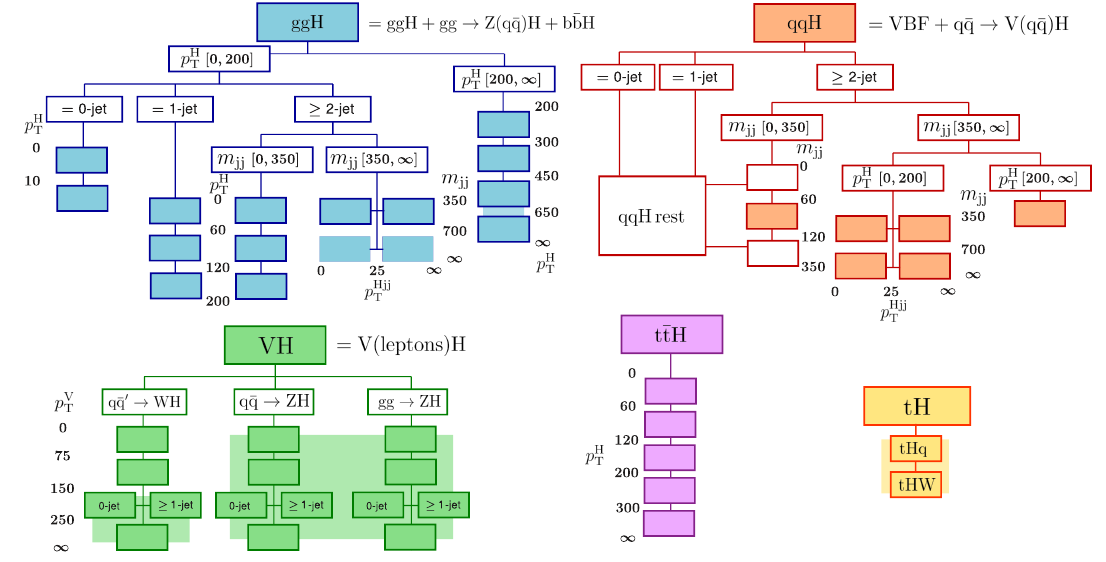
Figure 1 . Diagram showing the full set of STXS stage-1.2 bins, adapted from ref. [10], defined for events with | y | < 2 . 5 . The solid boxes represent each STXS stage-1.2 bin. The units of p H H , and p V are in GeV. The shaded regions indicate the STXS bins that are divided at stage 1.2, p H jj T T but are not measured independently in this